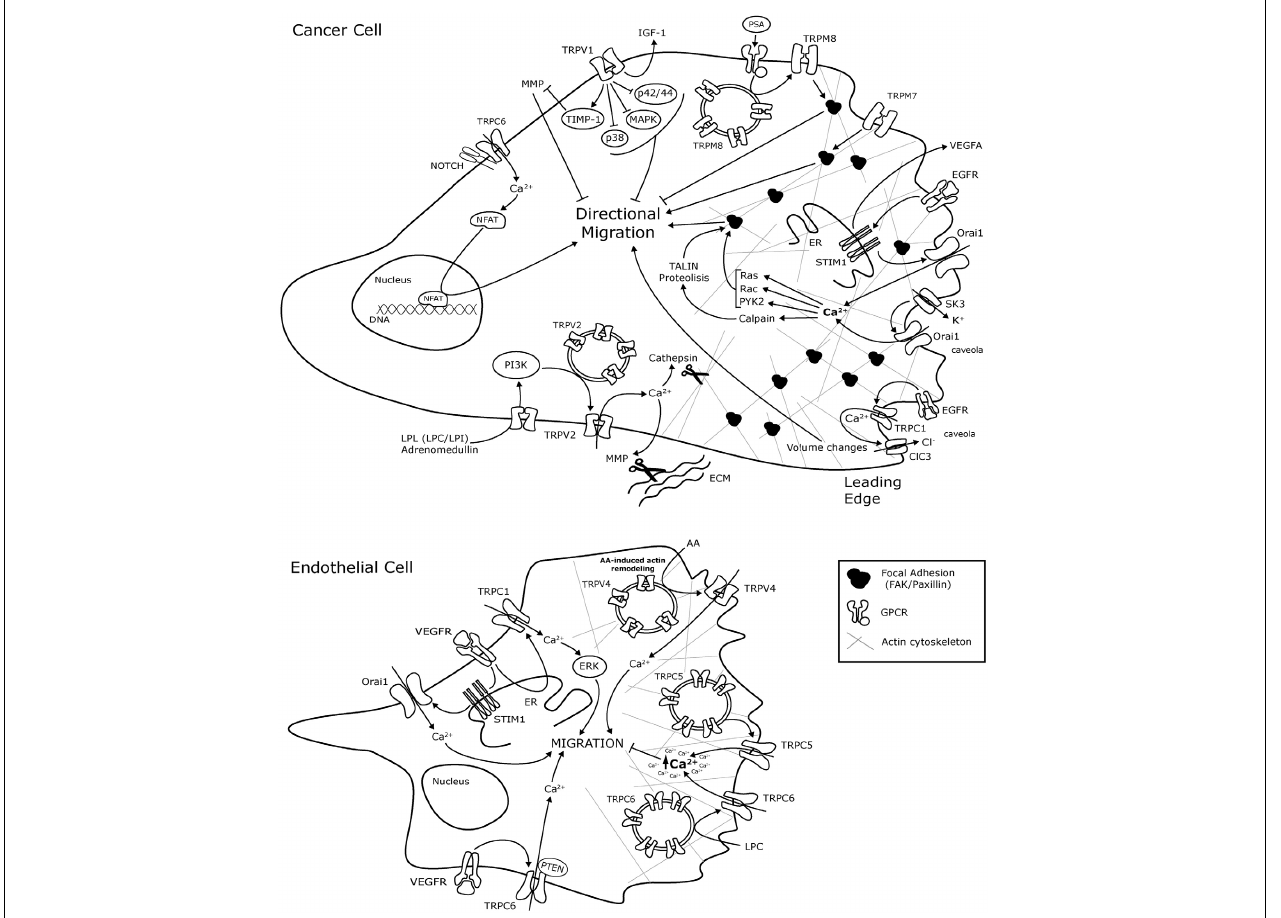
FIGURE 1 | Schematic representation of TRP and ORAI1 channels molecular mechanisms involved in cancer cell and endothelial cell migration. The mechanisms are presented in representative Cancer cells and endothelial cells without any tissue specification. AA, arachidonic acid; ClC-3, Chloride channel-3; EC, endothelial cells; ER, endoplasmic reticulum; bFGF, basic Fibriblast Growth Factor; GZMA, Granzyme A; GPCR, G-protein coupled receptor; IGF, insulin-like growth factor; LPL, lysophospholipids; LPC,